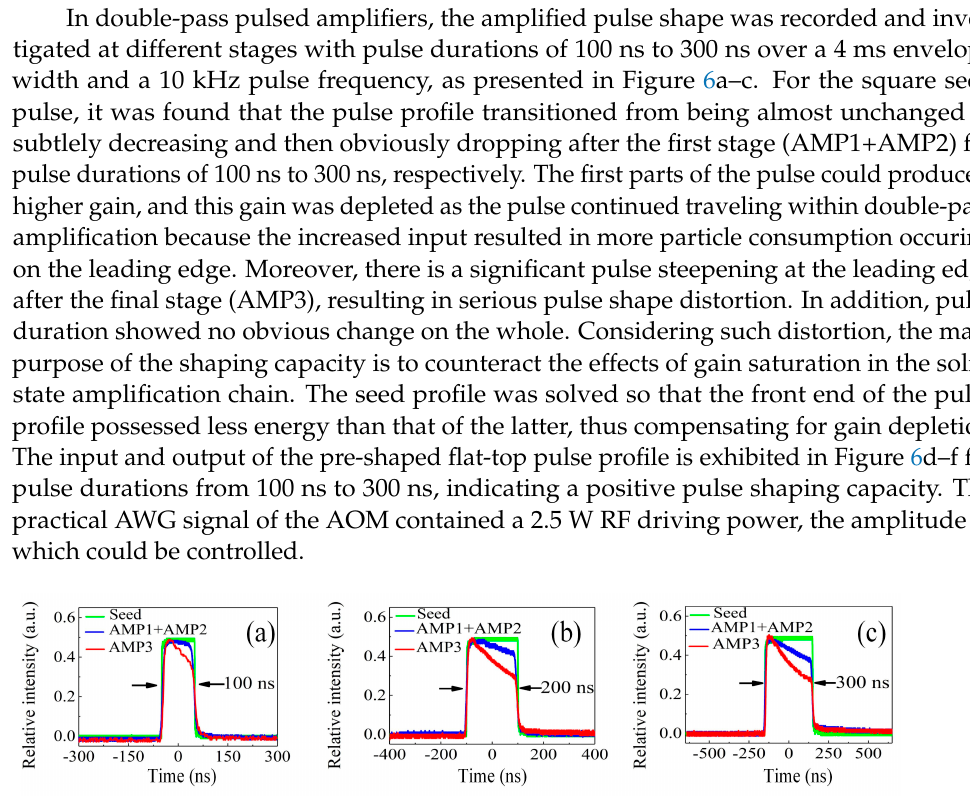
Figure 5. Input and output envelope of pre-shaped flat-top burst profile at amplification delays of 0.42 ms, 0.5 ms, and 0.6 ms. ( a – c ): Input profile of pre-shaped envelope; ( d – f ): Output profile of pre- shaped envelope.